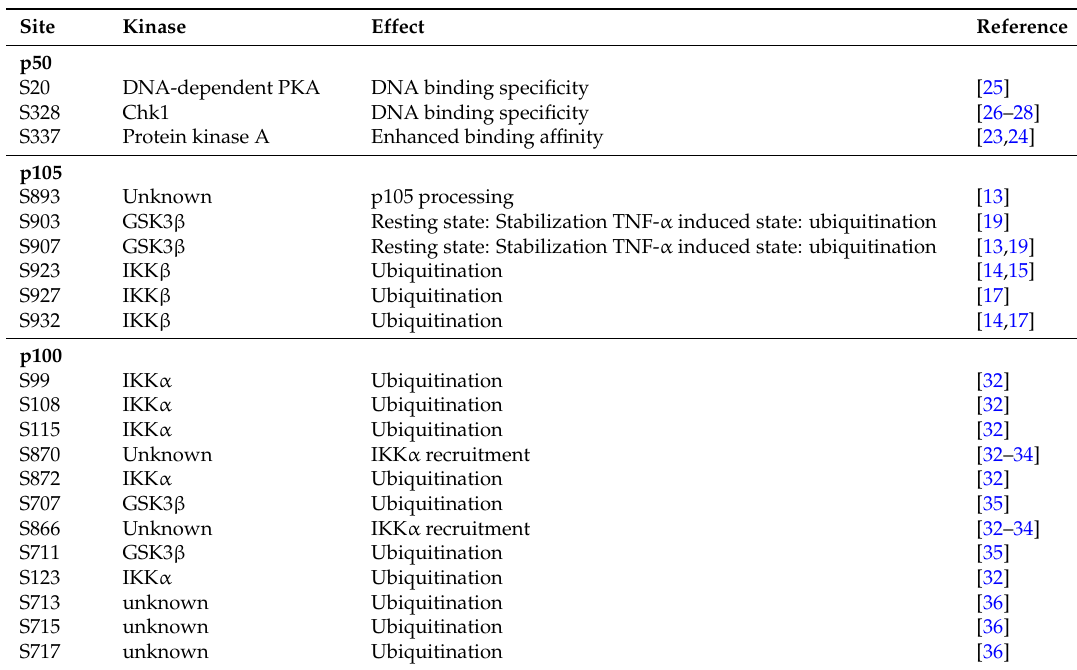
Table 1. Phosphorylations of the p50, p105 and p100 NF- κ B